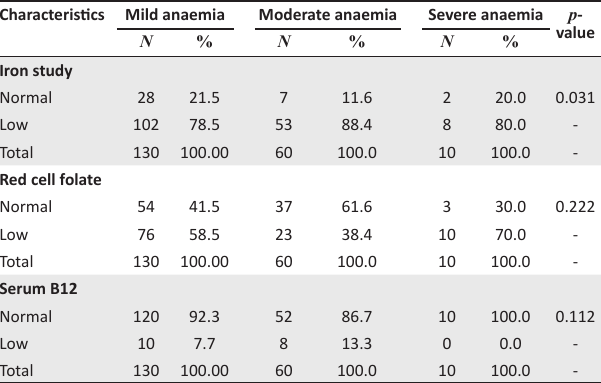
TABLE 5: Differences in the degree of anaemia with iron and vitamin levels, Sudan, September 2016 to February 2017. Characteristics Mild anaemia